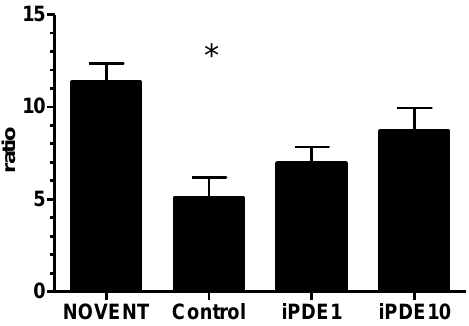
Figure 3. Wet/dry-ratio per group (mean ± SEM, * p < 0.05 vs. NOVENT).